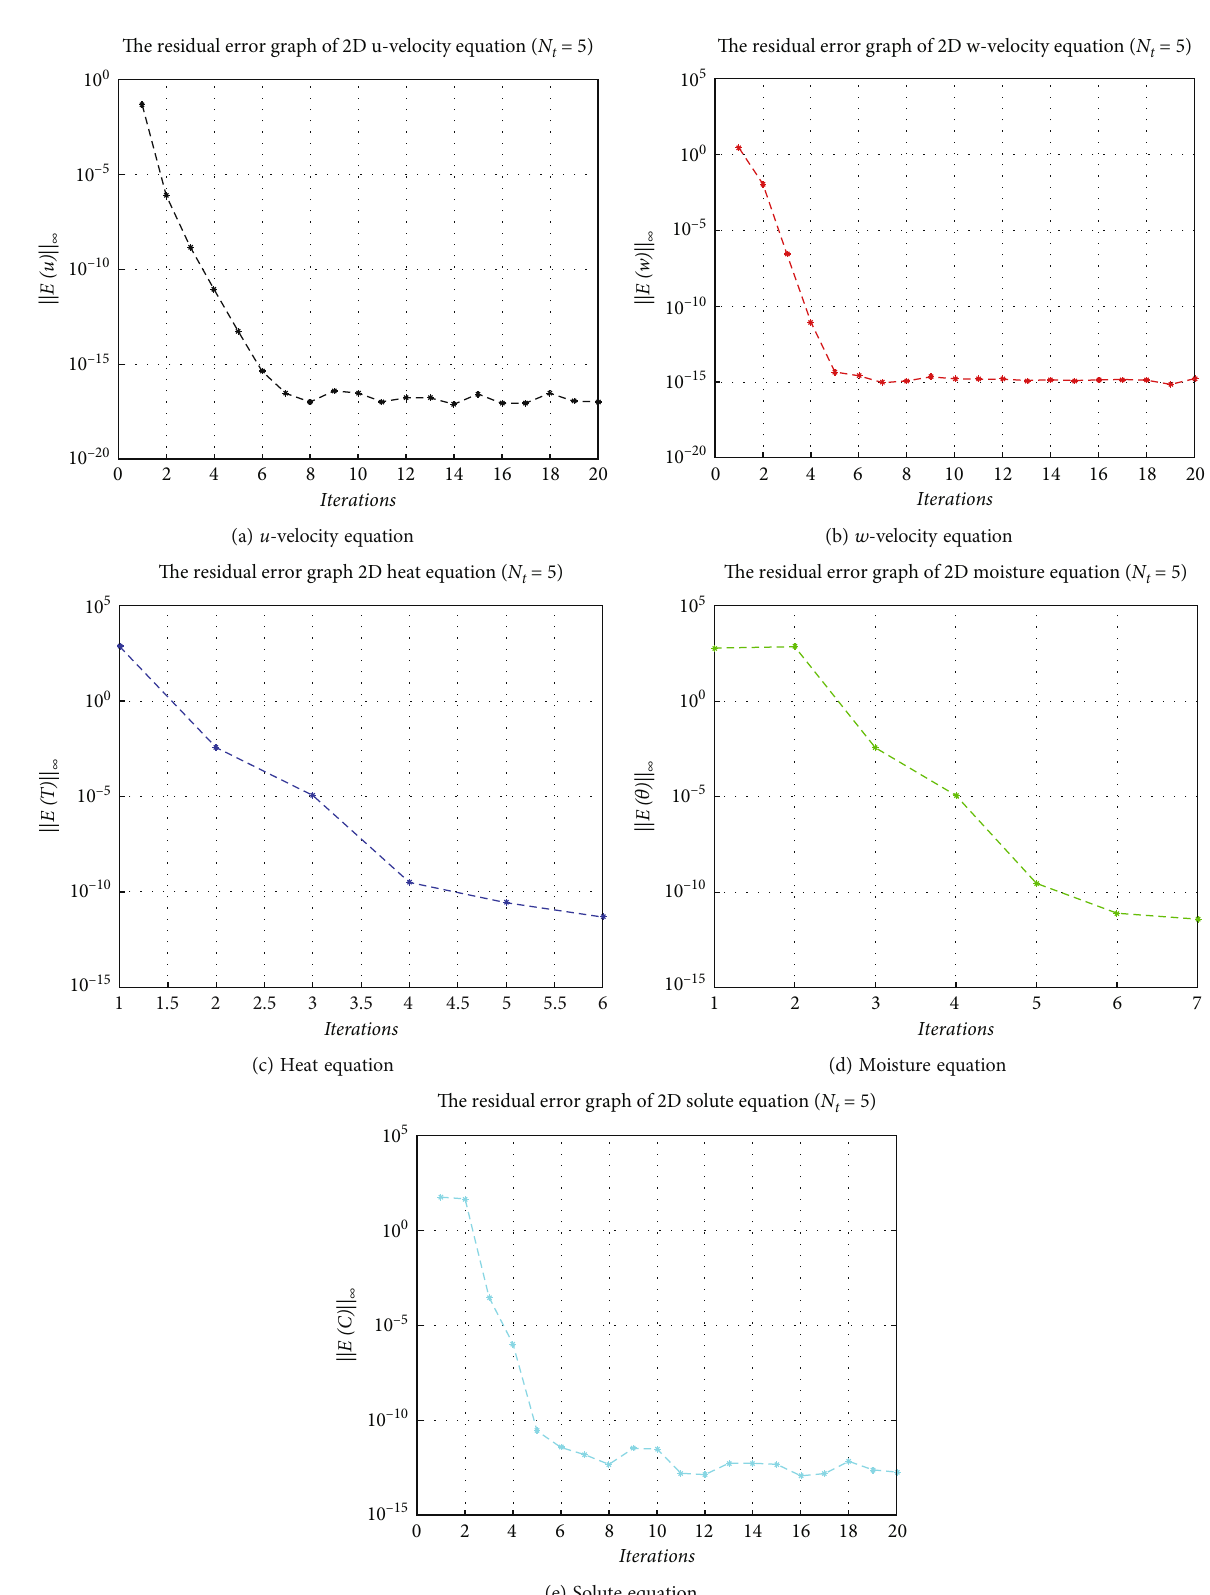
Figure 7: Error norms at di ff erent iteration points of the model, for N